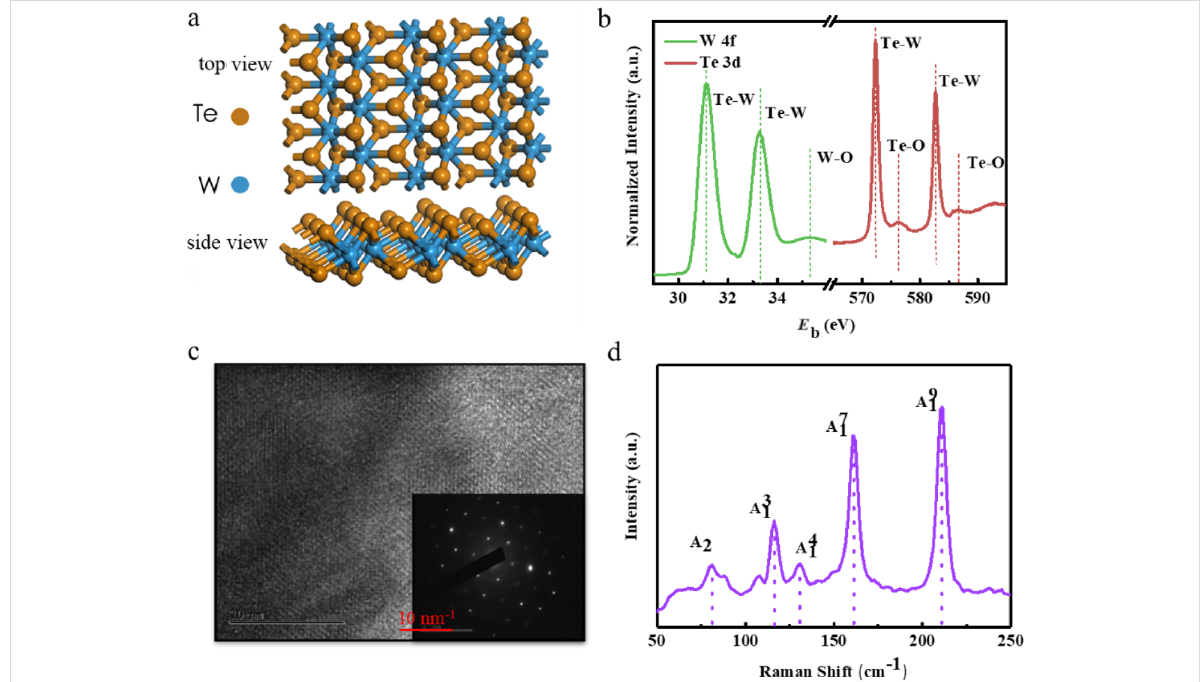
Figure 1: Topological phase and characterization of 1T’-WTe 2 . a) Side and top views of lattice structures of 1T’-WTe 2 . Brown spheres: tellurium atoms, blue spheres: tungsten atoms. b) XPS spectrum of W 4f (green line) and Te 3d (red line) peaks. c) TEM image and SEAD pattern of WTe 2 , revealing the crystal structure of the 1T’ phase, with lattice parameters a ≈ 3.49 Å and b ≈ 6.32 Å, respectively. d) Raman spectrum of a 1T’-WTe 2